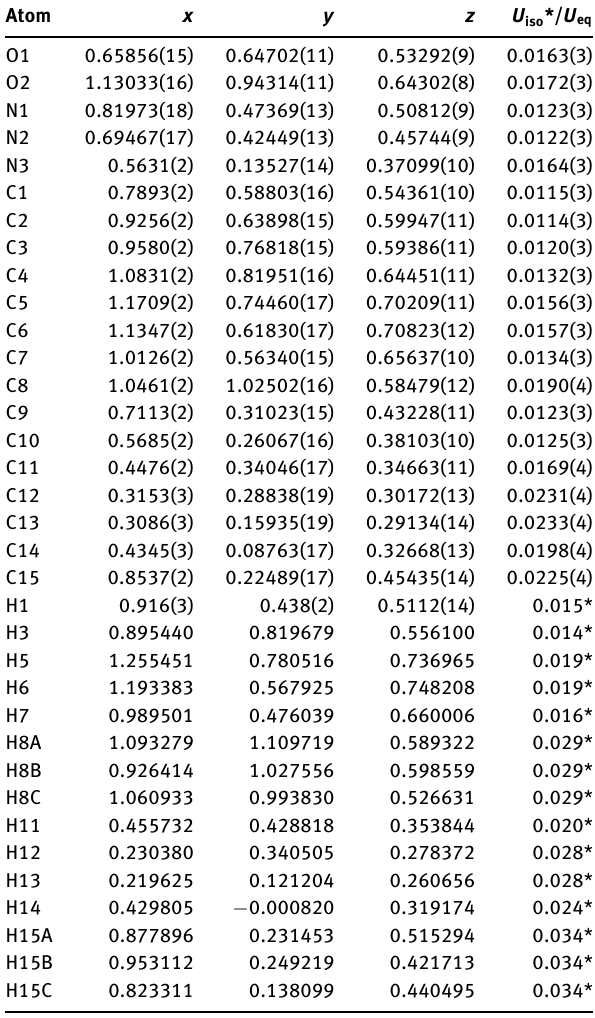
Table 2: Fractional atomic coordinates and isotropic or equivalent isotropic displacement parameters (Å 2